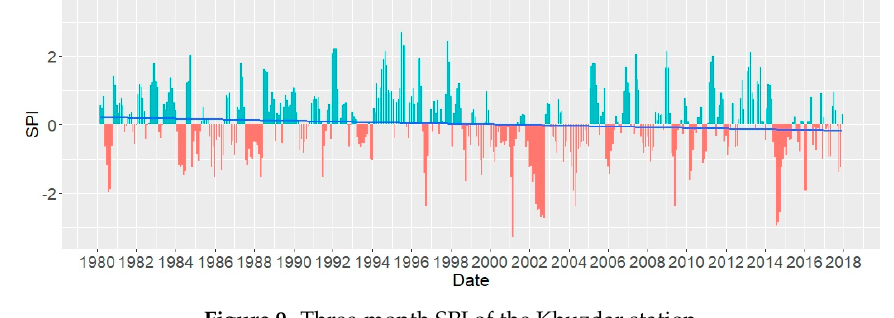
Figure 9. Three-month SPI of the Khuzdar station.